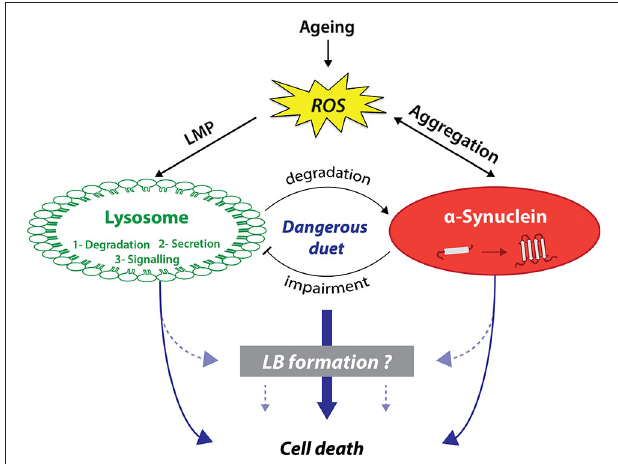
FIGURE 1 | Lysosomes and α -synuclein are involved in a vicious pathogenic loop eventually leading to cell death and LB formation . On the one hand, lysosomes have been shown to be involved in cell death activation through canonical or non-canonical pathways. On the other hand, α -synuclein ( α -syn) can also trigger cell death through several distinct pathways including membranes permeabilization. Lysosomes and α -syn display a bidirectional relationship. While lysosomes predominantly degrade α -syn, α -syn aggregation can lead to lysosomal dysfunction in return. α -Syn-mediated lysosome impairment can lead to alterations of one of lysosomal main function: protein degradation, lysosome-to-nucleus signaling, and secretion. This pathogenic loop can be worsened with age and in particular ROS production, which can induce both LMP and α -syn aggregation. Interestingly, α -syn aggregation, especially specific oligomeric species, can increase ROS production. We previously suggested that this loop might be the template for the formation of LB, which remains currently